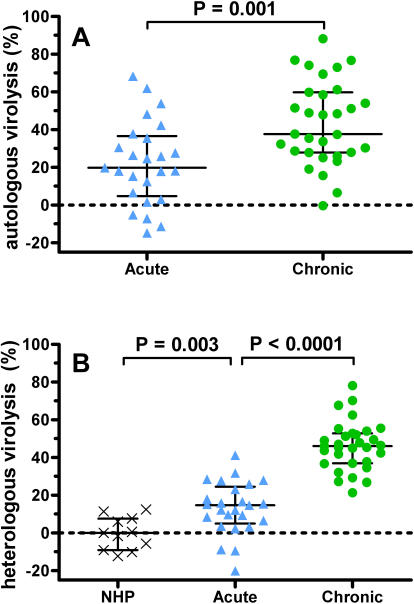
Lysis Activity against Virus in Plasma of Acutely and Chronically Infected PatientsComplement-mediated lysis activity against autologous (A) and heterologous (JR-FL) (B) virus was compared between acutely (blue triangles) and chronically (green circles) infected individuals. HIV-specific lysis activity is present at acute and chronic diseases stages but generally higher during chronic infection. Crosses denote uninfected plasma controls. Groups were compared using Mann-Whitney U test.